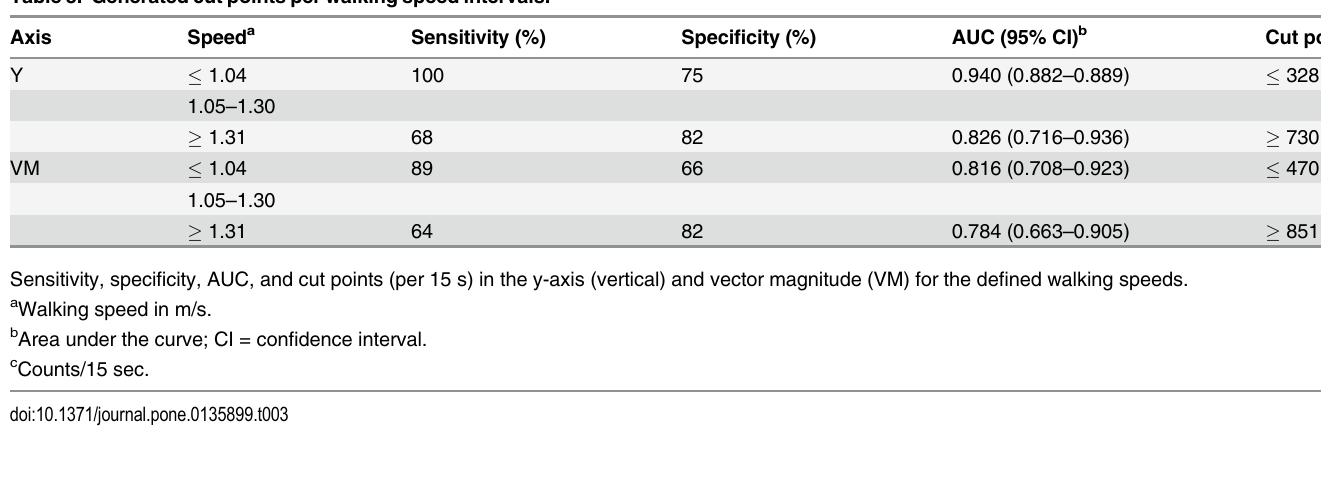
To our knowledge, this is the first study to provide accelerometer cut points for different walk- and < 470 counts/15 sec, and for walking speed > 1.3 m/s they were > 730 and > 851 counts/ 15 sec for the y-axis and VM, respectively. The leave-one-out cross-validation showed substan- tial agreement between true and cut-point-defined walking speeds. The resultant cut points may be used to quantify physical activity behaviour in this population and to ascertain regular free-living walking speed for older adults with mild to moderate PD. Accelerometer cut points for different types of units and populations can be found in the lit- erature [39, 45, 46], including cut points for the Actigraph GT3X and GT3X+ for older adults Table 3. Generated cut points per walking speed intervals.